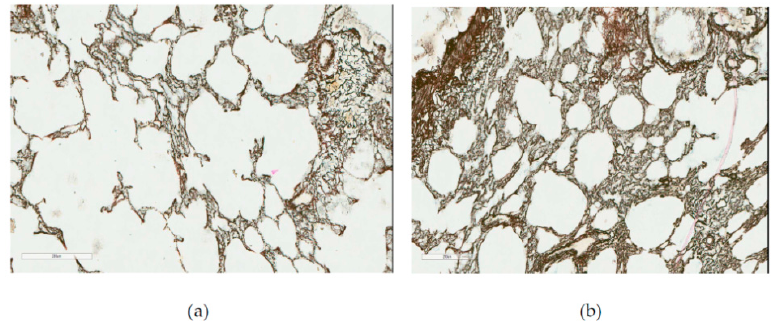
Figure 6. Rat lungs ( a ) after 10-month inhalation exposure to NiO-NPs and ( b ) in the control group of the same exposure period. Gomori’s silver impregnation, magnification: 400×. See description in the text.